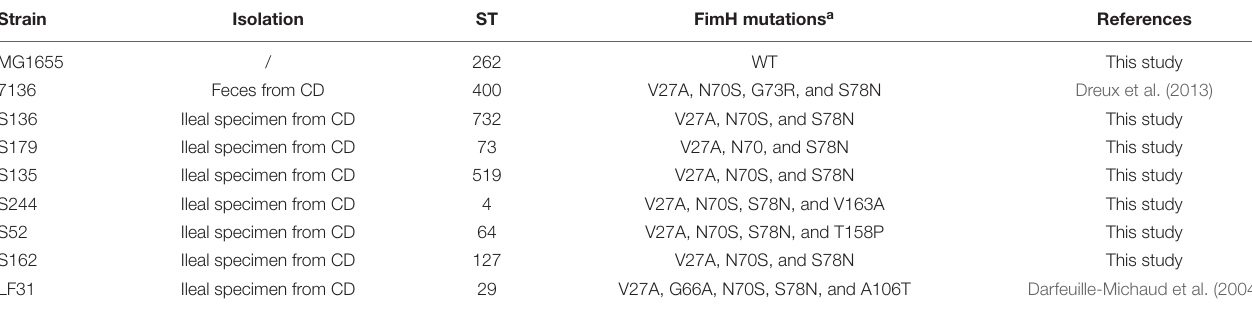
TABLE 1 | Description of AIEC strains selected for the study.